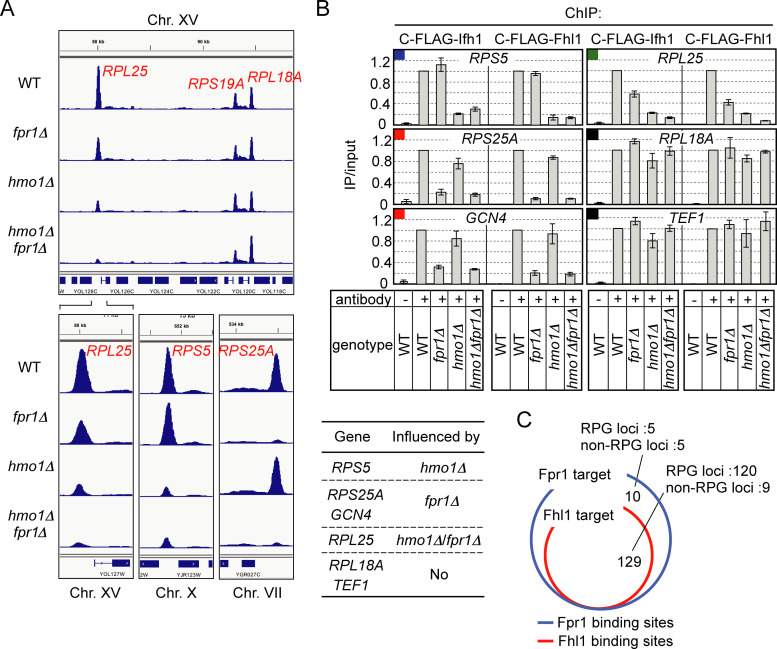
Effect of deletion of HMO1 and/or FPR1 on Fhl1/Ifh1 binding to specific RPG promoters.(A) To examine whether Fhl1 binding to RPG promoters is influenced by deletion of HMO1 and/or FPR1, ChIP-seq analyses of Fhl1 were conducted in WT, fpr1Δ, hmo1Δ, and hmo1Δfpr1Δ cells expressing C-terminally FLAG (3×)-tagged Fhl1 (YKK1090, YKK1087, YKK1091, and YKK1086, respectively), as described in the legend for Fig 1B and the Methods section. The binding positions of Fpr1 and Fhl1 in the entire genome are shown in S2 Fig; part of Chr. XV is enlarged and displayed in the upper panel. Binding peaks of Fhl1 at the promoters of RPL25 (Chr. XV), RPS5 (Chr. X), and RPS25A (Chr. VII) are enlarged and displayed in the bottom panels. (B) Fhl1/Ifh1 binding to certain Fpr1-target promoters in WT, fpr1Δ, hmo1Δ, and hmo1Δfpr1Δ cells was examined by ChIP assays using either the strains listed in (A) or strains expressing C-terminally FLAG (3×)-tagged Ifh1 (YKK1100, YKK1102, YKK1104, and YKK1106). The influence of deletion of HMO1 and/or FPR1 on Fhl1/Ifh1 binding to the tested promoters is summarized in a table under the graphs. The coloured symbols at the top of each panel reflect the classification of Fpr1-target genes, as described in S3 Fig. (C) Venn diagram of genes targeted by Fpr1 and Fhl1. The number of target loci corresponding to each sector identified by ChIP-seq is indicated.